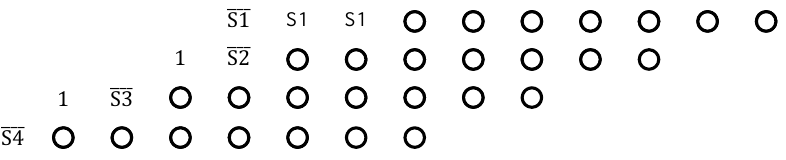
Figure 4. Generation of modified partial products for Radix-4 booth